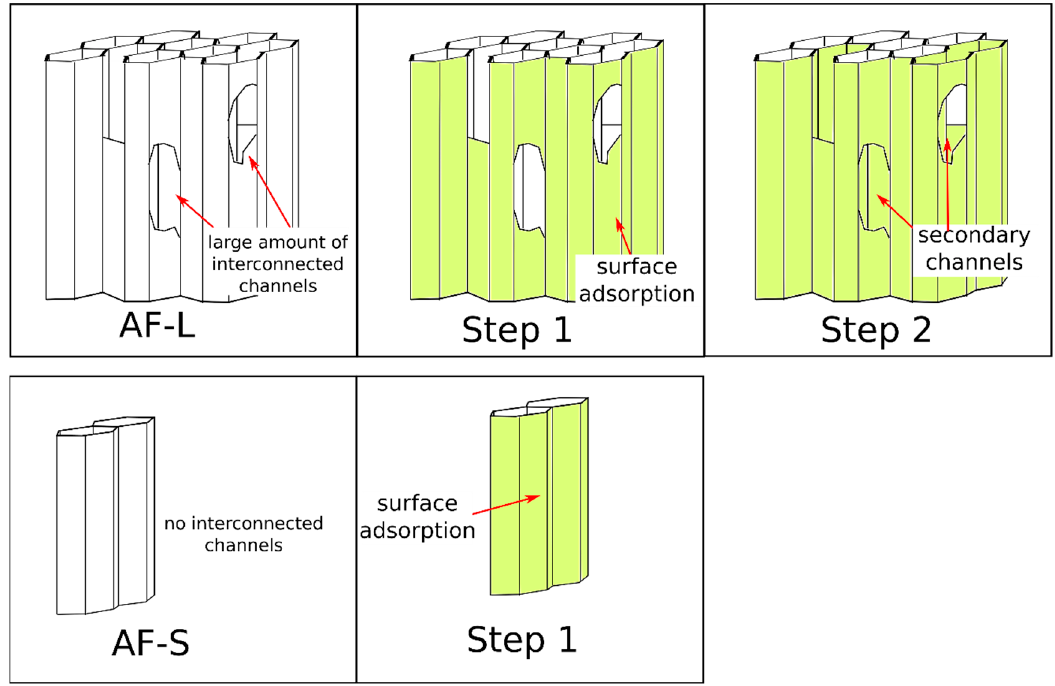
Figure 8. Sorption mechanism for AF-L and AF-S samples.